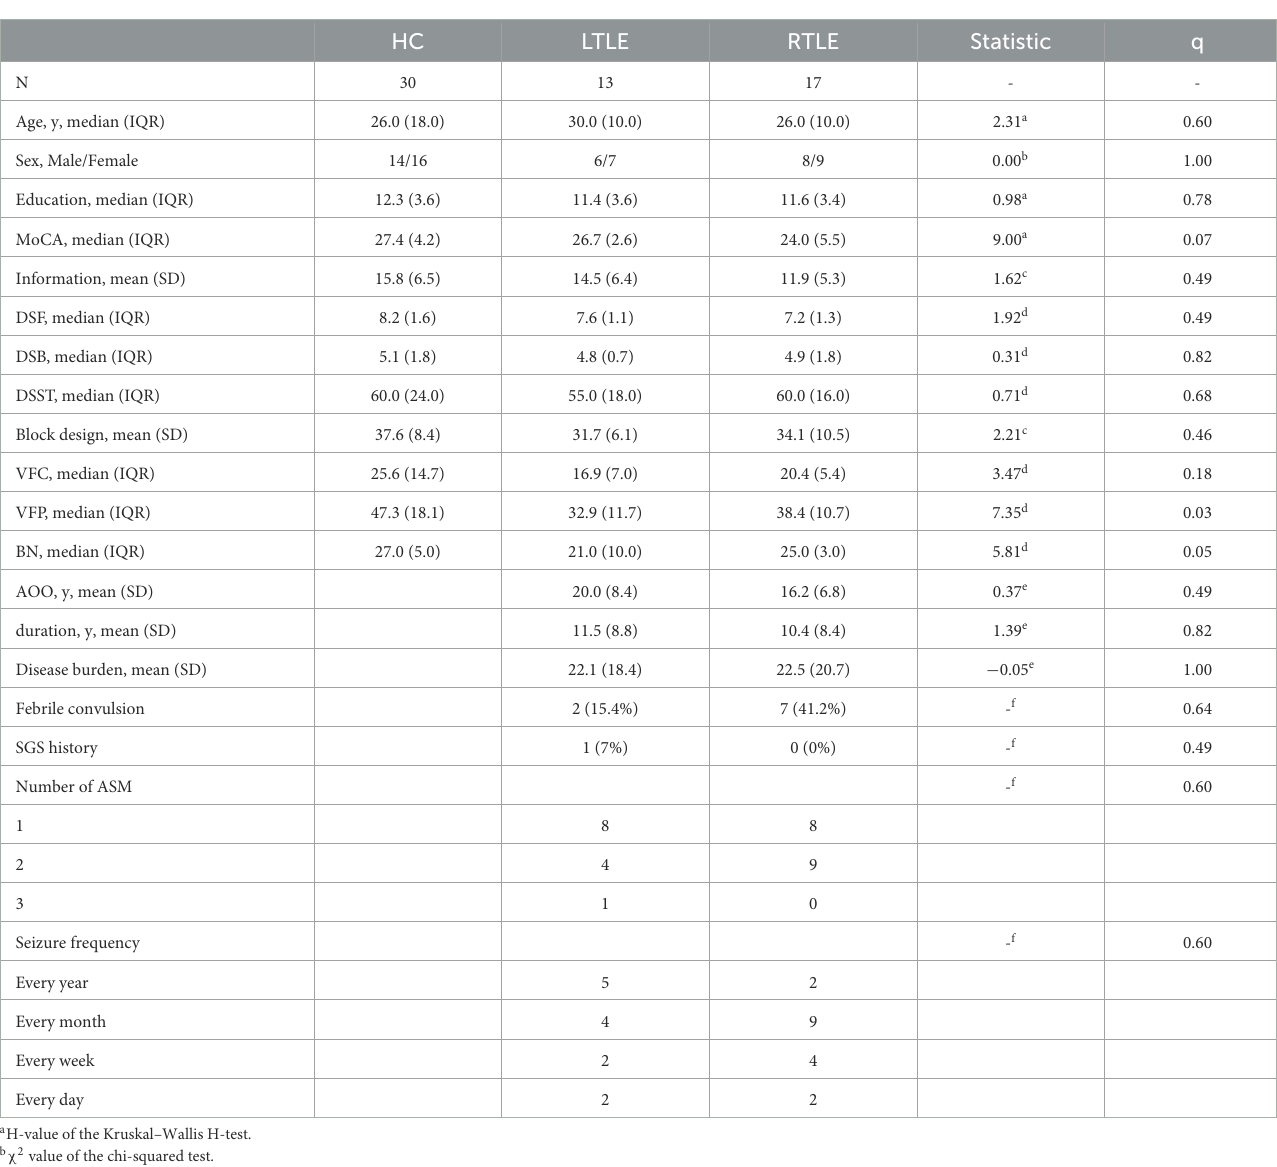
TABLE 1 Participant demographic and clinical